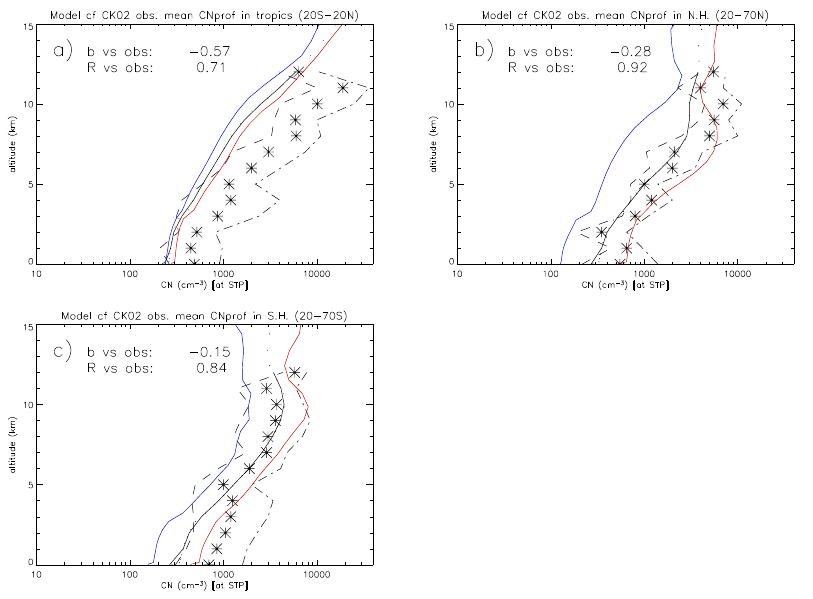
Fig. 21. Simulated CN profiles (solid lines) over the Pacific and Southern Oceans compared to aircraft observations (asterisks are median, dashed/dot-dashed lines represent ± 1 standard deviation) in the latitude ranges (a) 135–180 ◦ E, (b) 175–270 ◦ E and (c) 200–240 ◦ E (Clarke and Kapustin, 2002). Simulated CN (particles larger than 3nm dry diameter) were averaged on each model level for the three regions, as in Spracklen et al. (2005). Values of b and R are shown for each region from model values interpolated to a 1km grid to match the observations. The black line shows simulated annual mean profile and the blue/red lines show minimum/maximum monthly-mean